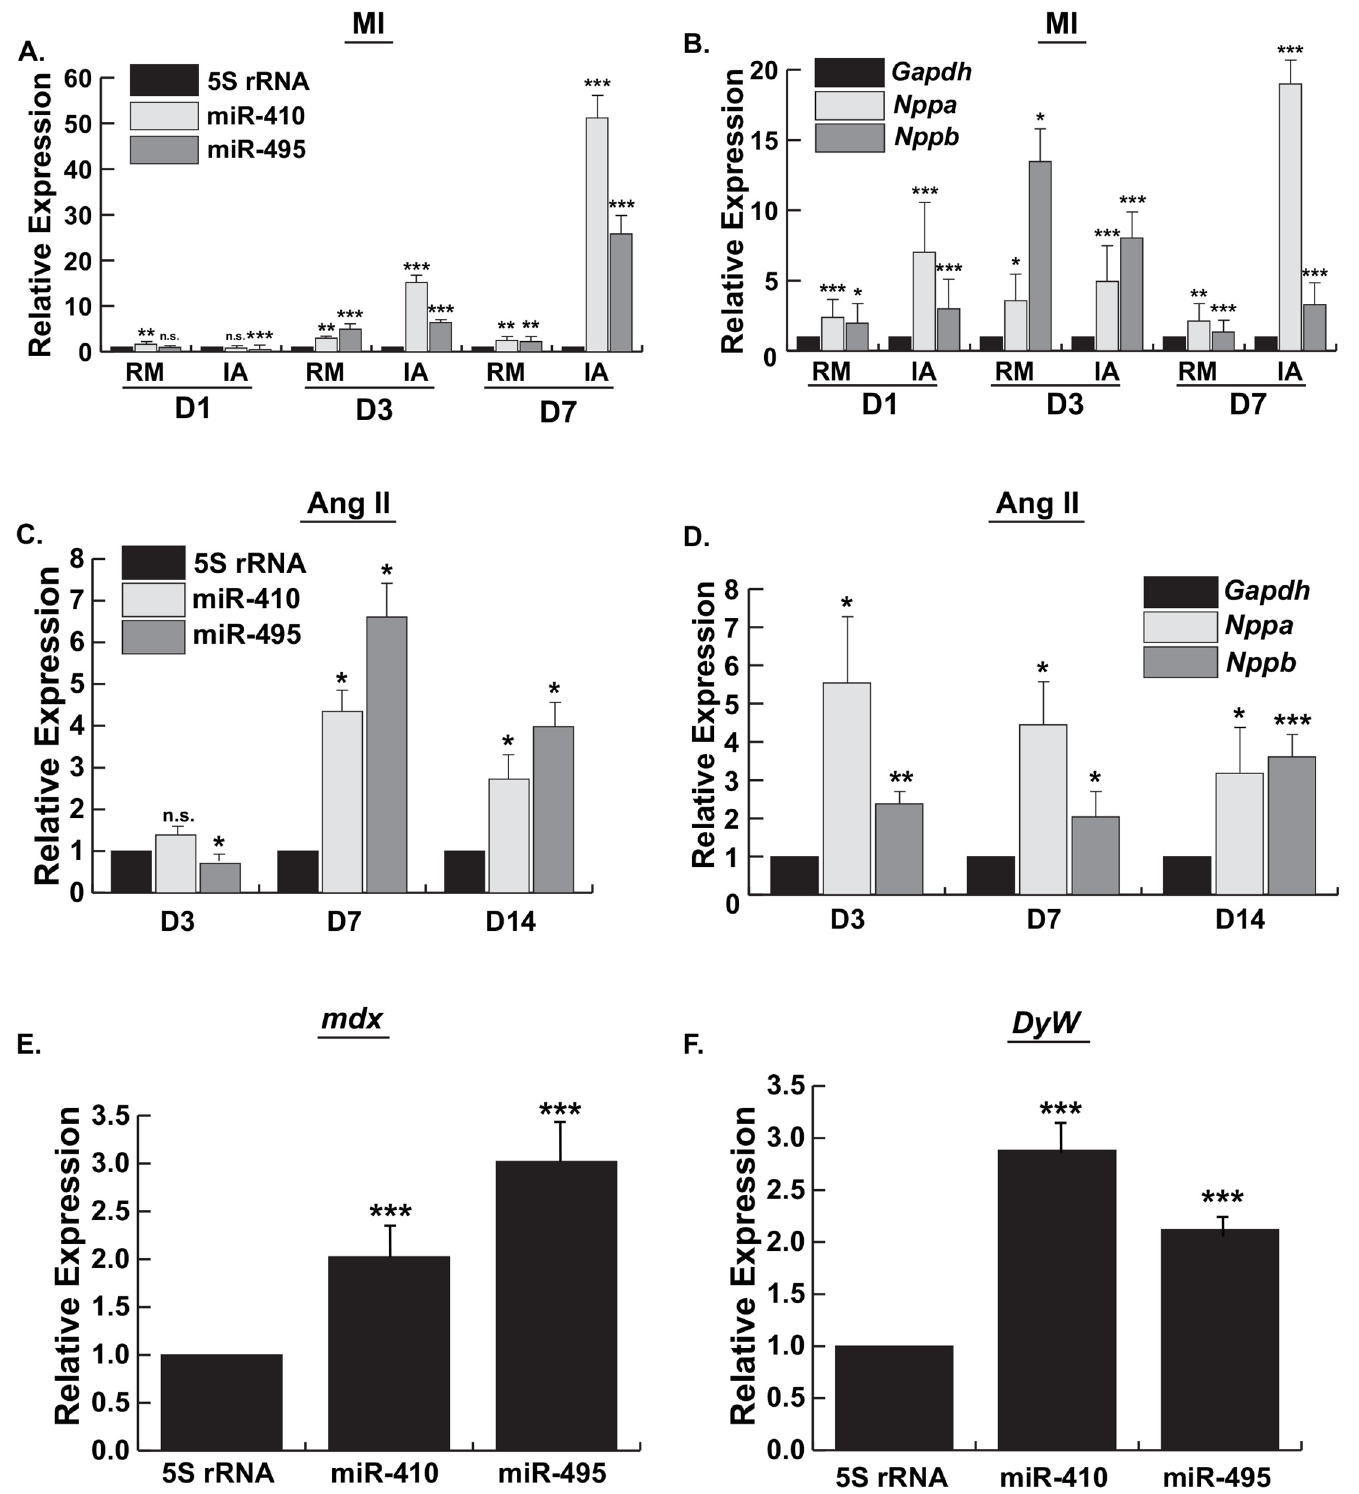
Fig 1. Gtl2-Dio3 miRNAs are dynamically regulated in diverse cardiomyopathies. A and B , Quantitative RT-PCR expression of miR-410 and miR-495 ( A ), and the hypertrophy marker genes Nppa and Nppb ( B ), 1, 3, and 7 days post-myocardial infarction (MI) compared to sham-operated control. Values normalized to 5S RNA. RM, remote area; IA, infarcted area. C and D , Quantitative RT-PCR expression of miR-410 and miR-495 ( C ), and Nppa and Nppb